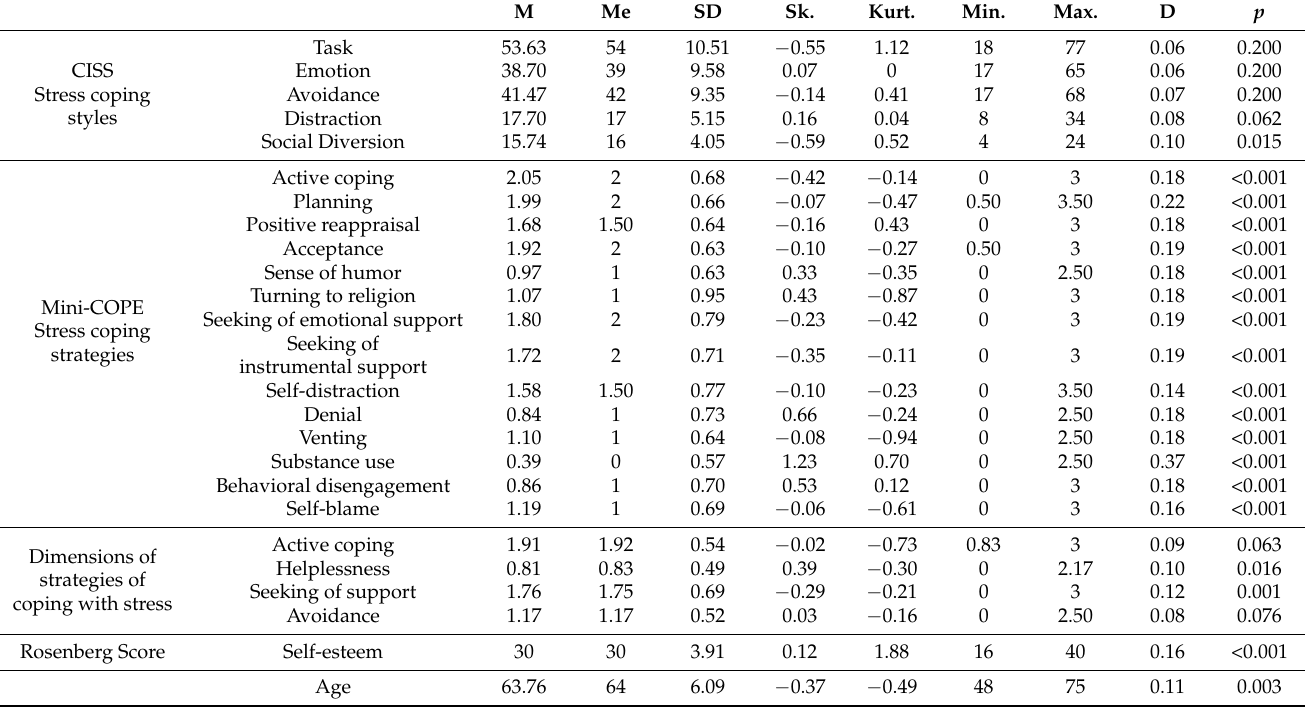
Table 3. Basic descriptive statistics for the quantitative variables.